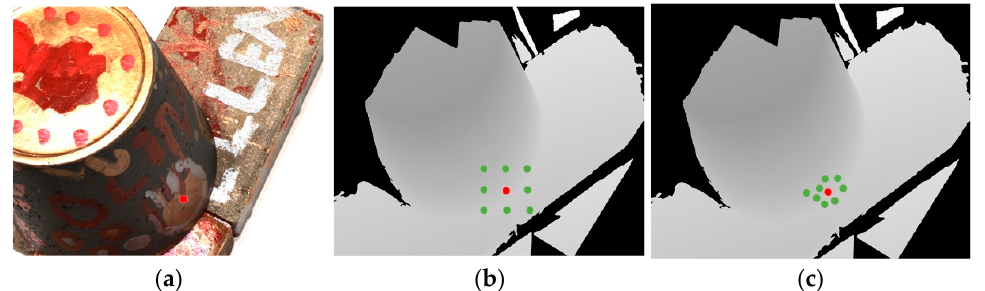
Figure 2. Example of adaptive propagation method: ( a ) means selecting a point on the original image; ( b ) conventional propagation method; ( c ) adaptive propagation method.